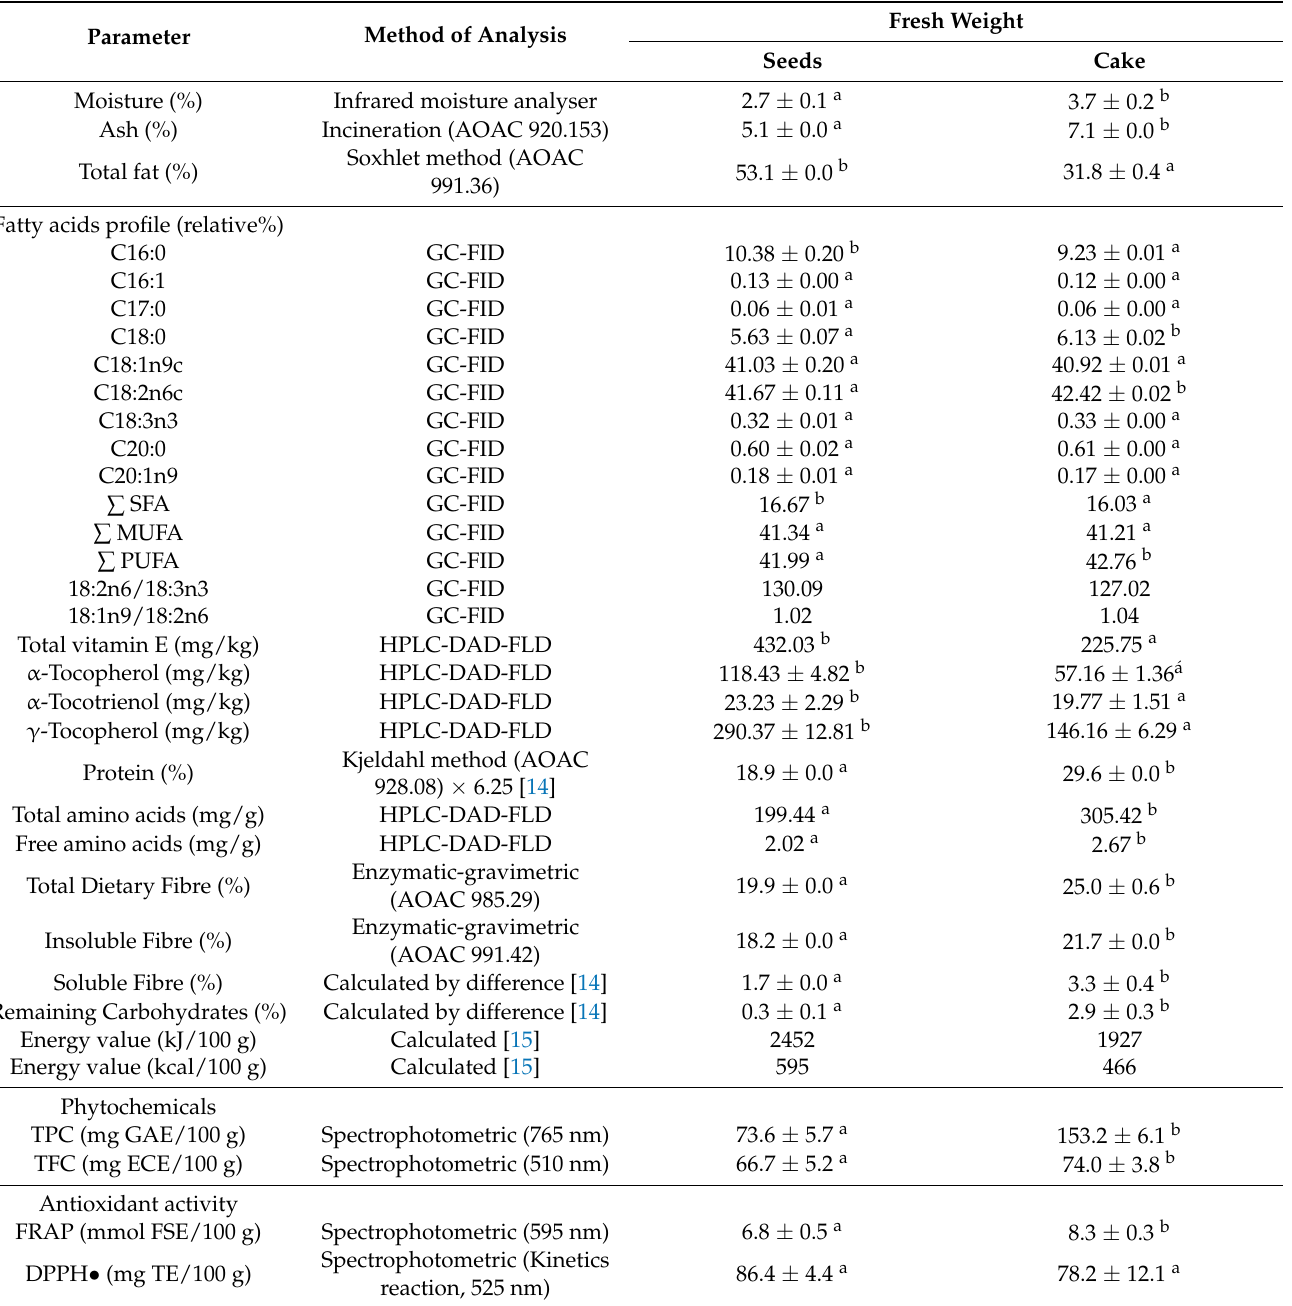
Table 1. Chemical analysis of sesame seeds and